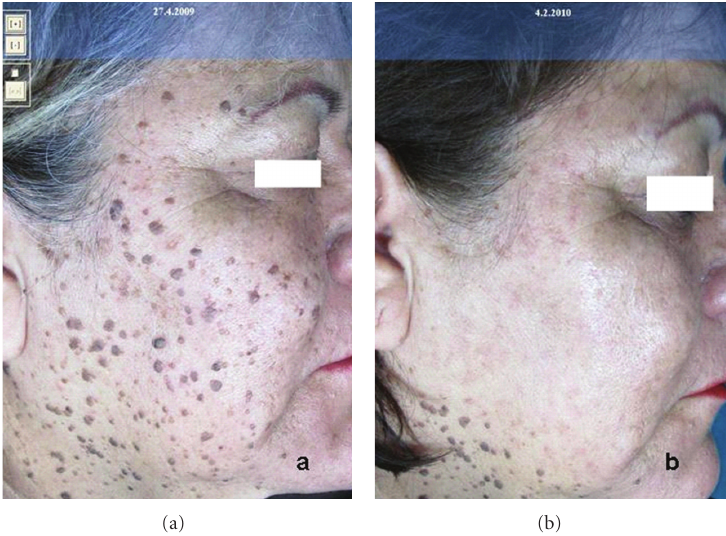
Figure 4: Dermatosis papulosa nigra at first (a) and after one (b) treatment with CO 2